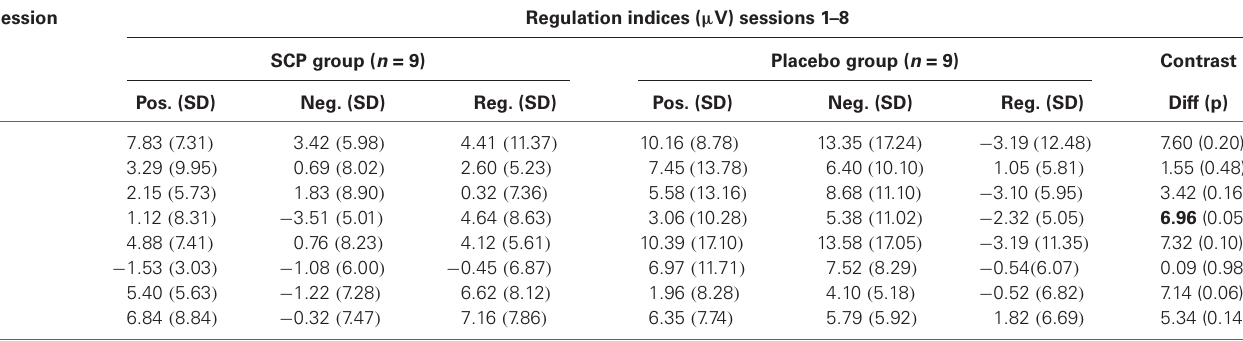
Table 2 | Regulation performance during SCP training sessions